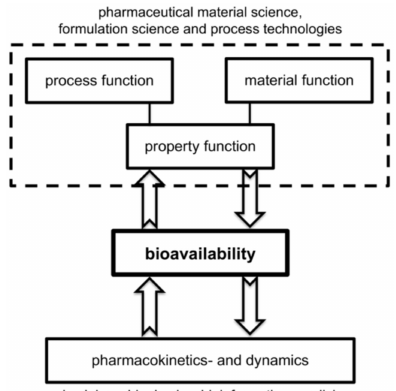
Figure 1. Long-term objective for quantitative prediction of bioavailability via the interplay of models for process technologies of active pharmaceutical ingredients (API) production and whole-body pharmacological